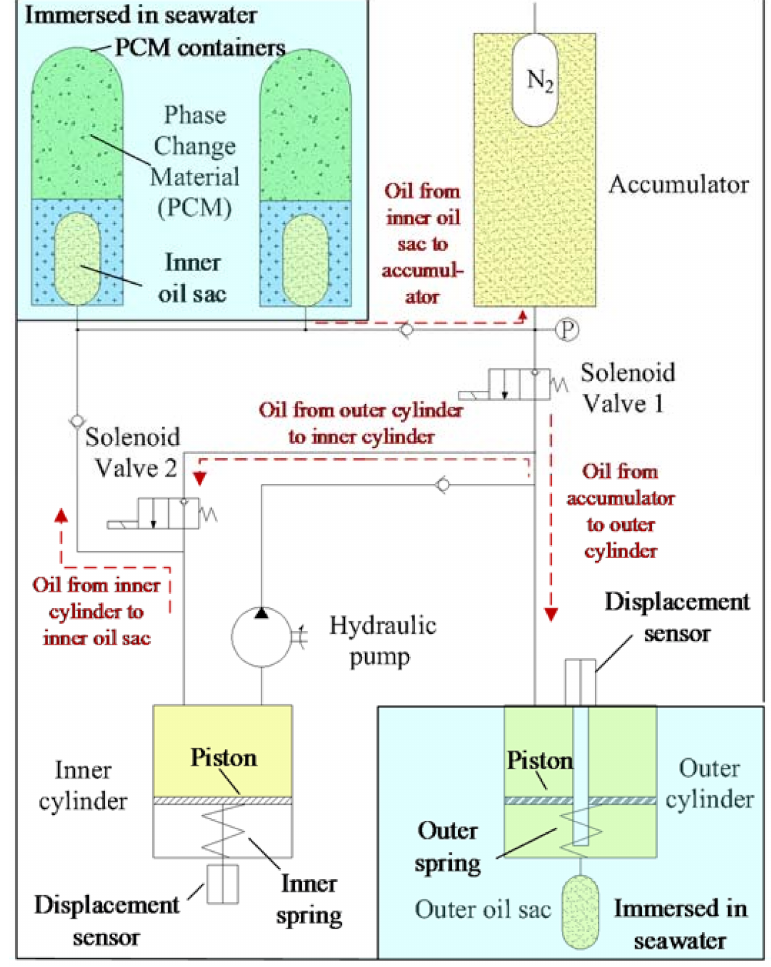
Figure 1. Principle diagram of the buoyancy adjustment